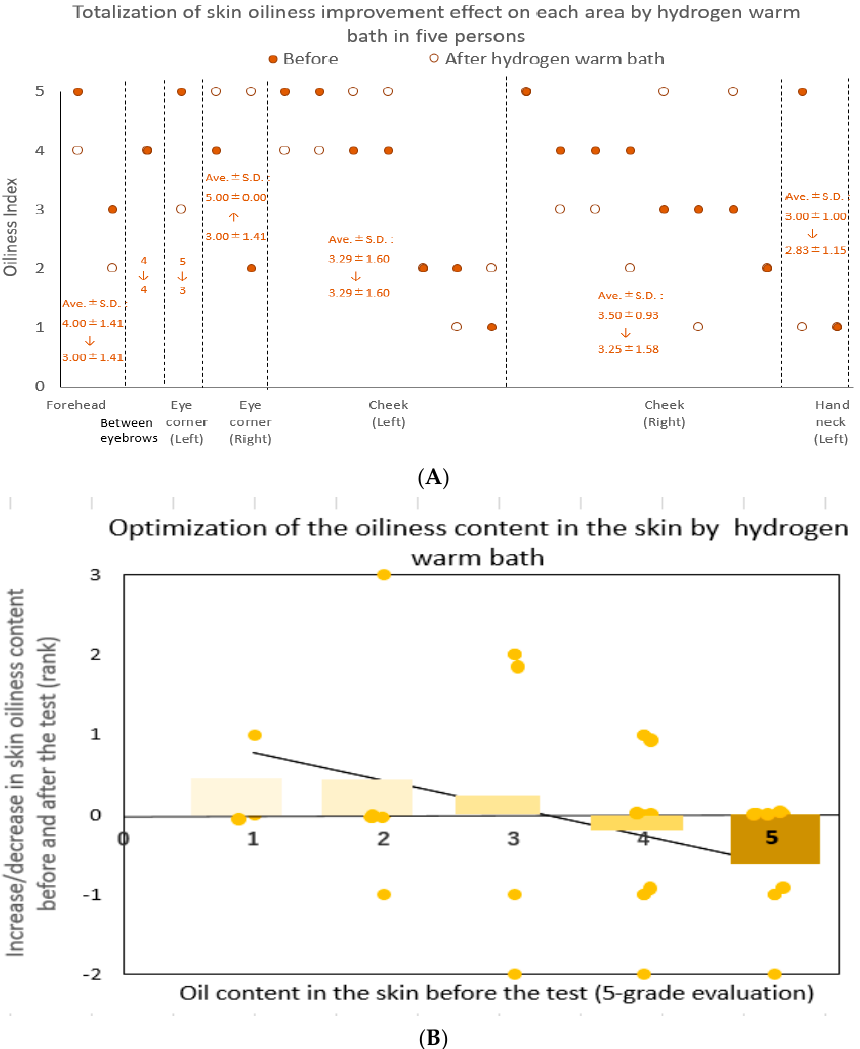
Figure 5. Optimization for the skin-oiliness contents by hydrogen-rich warm-water bath together with the poultice on the concerned skin parts. ( A ): Dot graph indicating change in the rank of the oiliness content with five degrees before and after bathing as divided into seven skin regions of all subjects. Vertical axis shows the oiliness index, while horizontal axis shows the numbering of analyzed areas for each subject, as follows; 1: forehead, 2: between eyebrows, 3: eye corner (left), 4: eye corner (right), 5: cheek (left), 6: cheek (right), 7: hand neck (left). ( B ): Dot graph indicating change in the rank of the oiliness content for 23 skin loci. The horizontal axis shows the degrees (0–5) before hydrogen application, while the longitudinal axis shows the change in the degrees. The negative correlation was observed between the original oiliness content and change in the rank, with a correlation coefficient: −